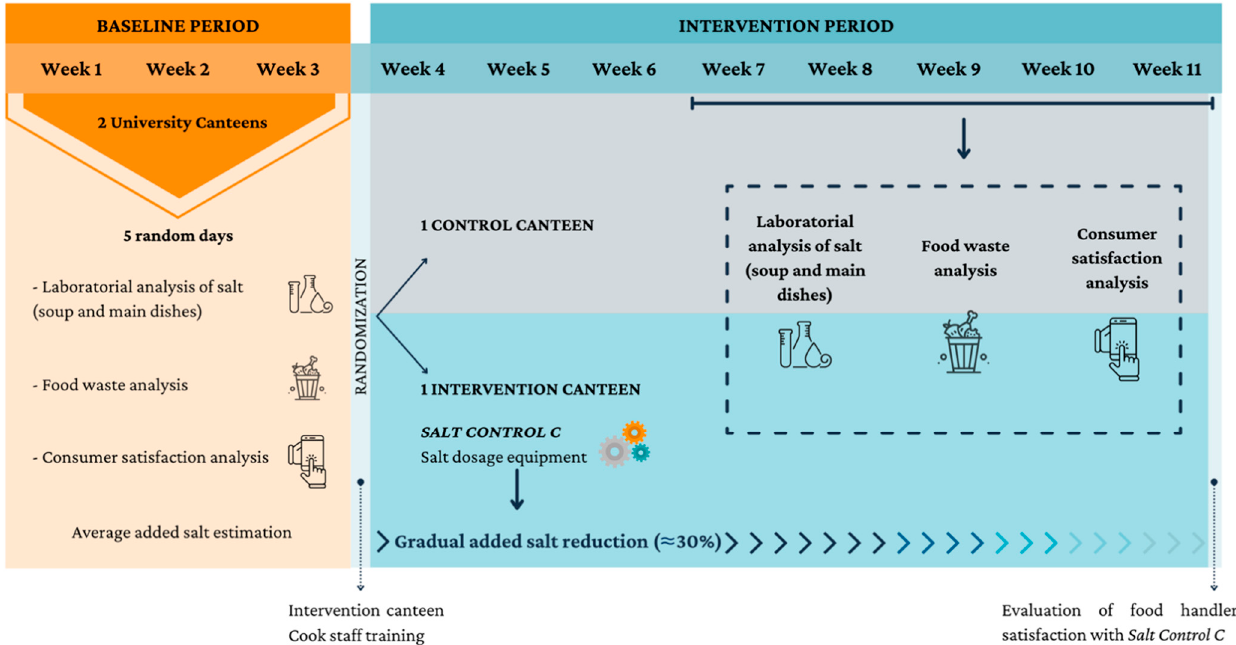
Figure 1. Flowchart with study